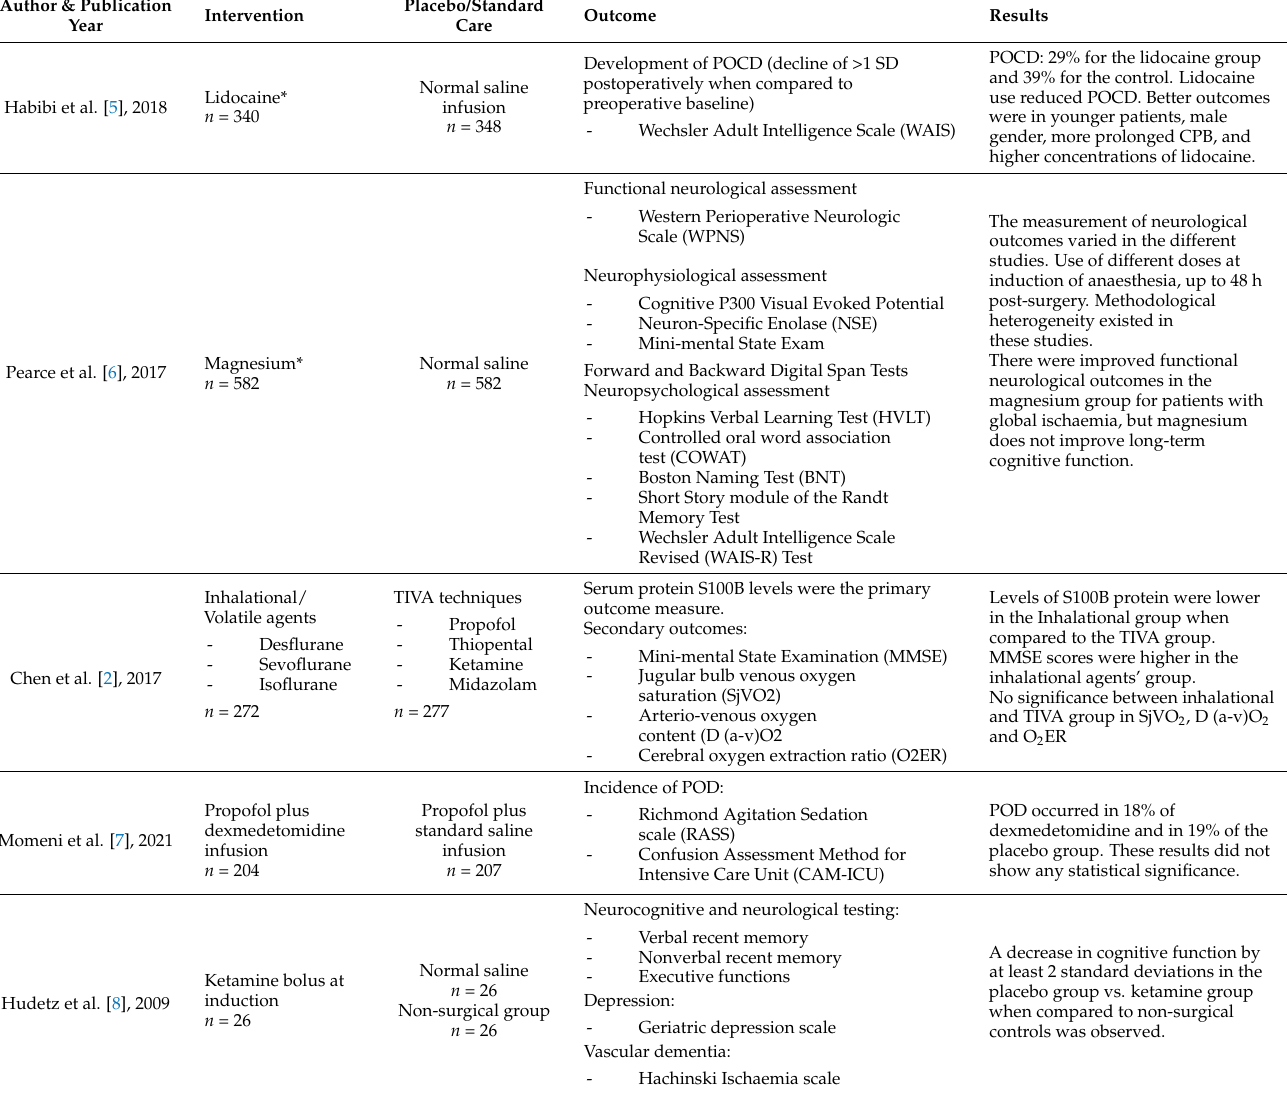
Table 1. Summary of randomised control trials comparing interventions to standard therapy for neuroprotection in cardiac